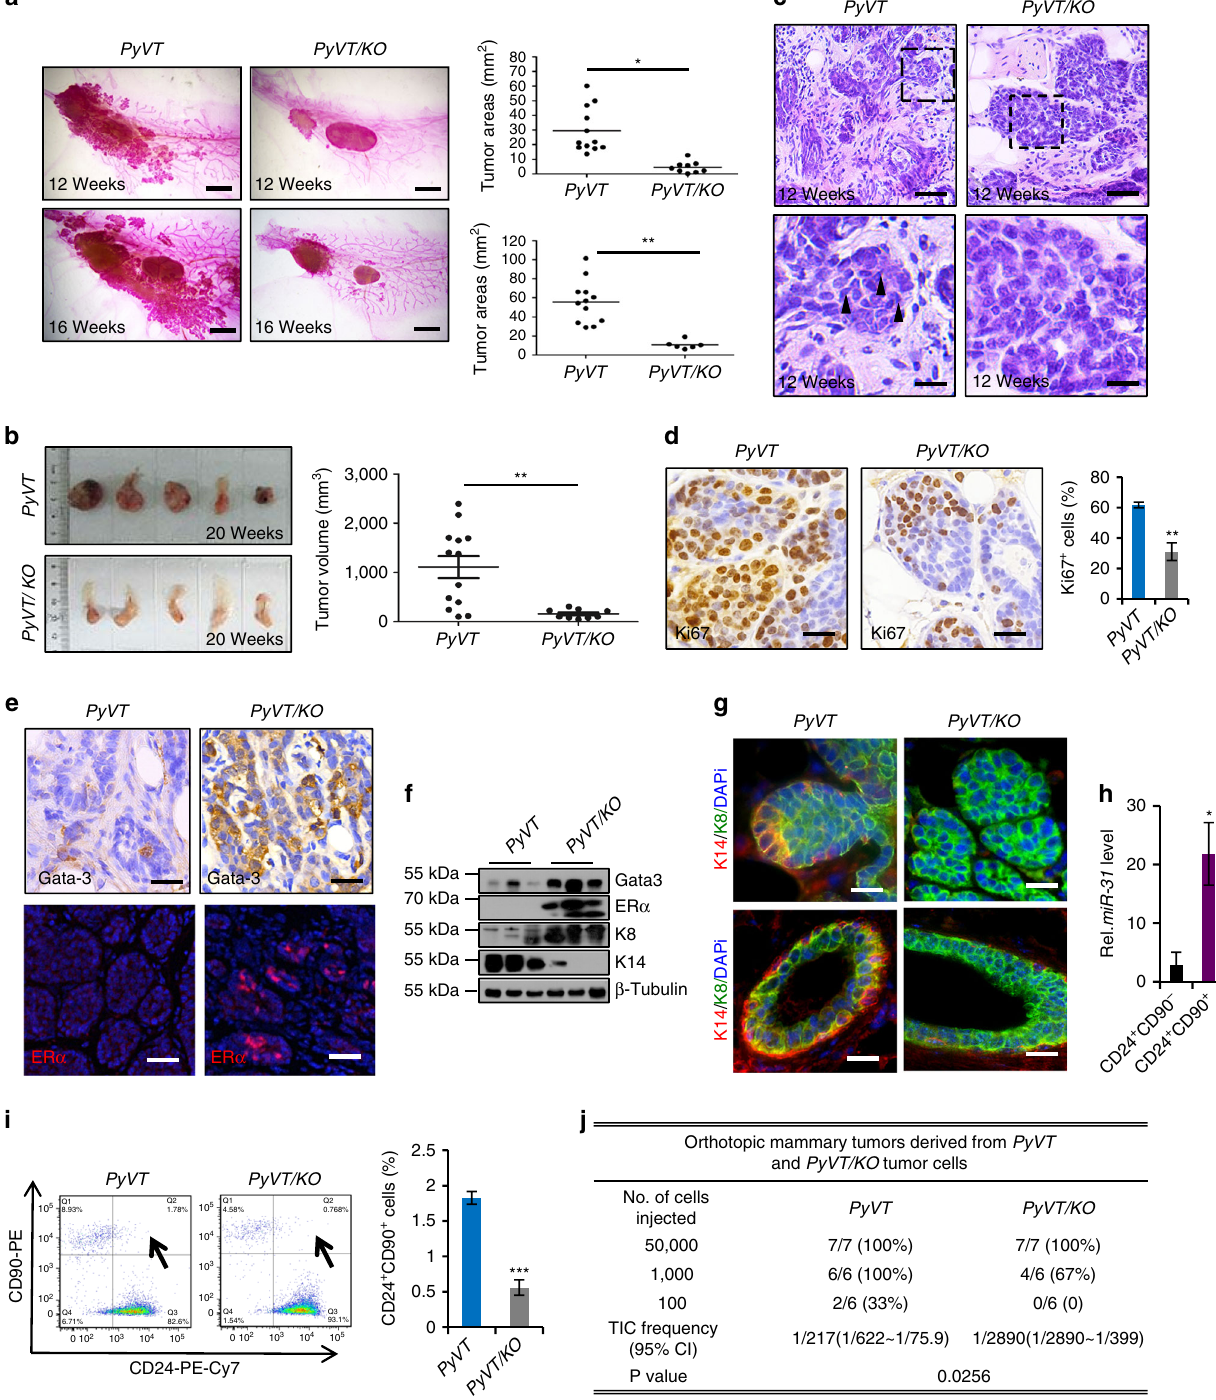
NATURE COMMUNICATIONS | 8:1036 | DOI: 10.1038/s41467-017-01059-5 |